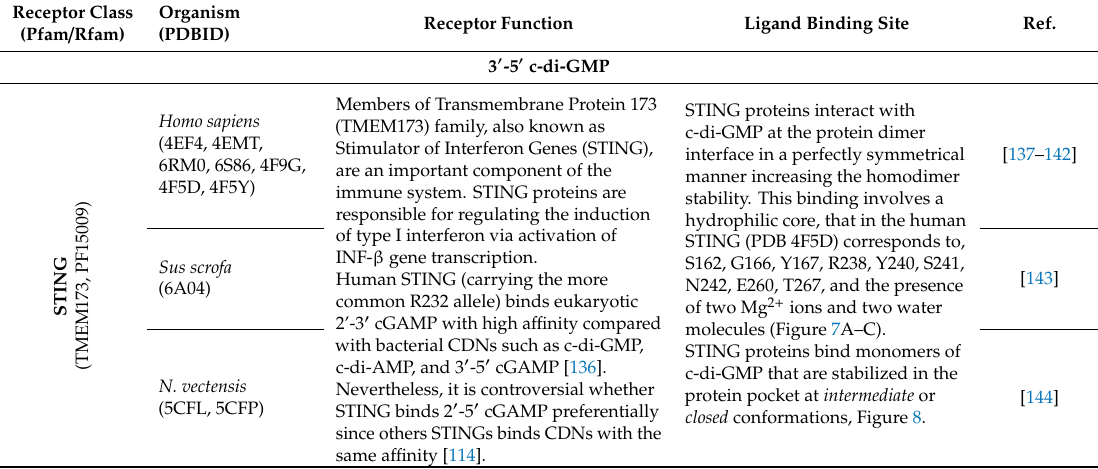
Table 1. List of the bacterial c-di-GMP, c-di-AMP, cGAMP, and eukaryotic cGAMP receptors that had their structure solved in complex with their ligand and deposited in the Protein Data Bank (PDB). The Pfam / Rfam and, in some cases, the InterPro domain is described. The residues involved in ligand binding are also described for a representative of each